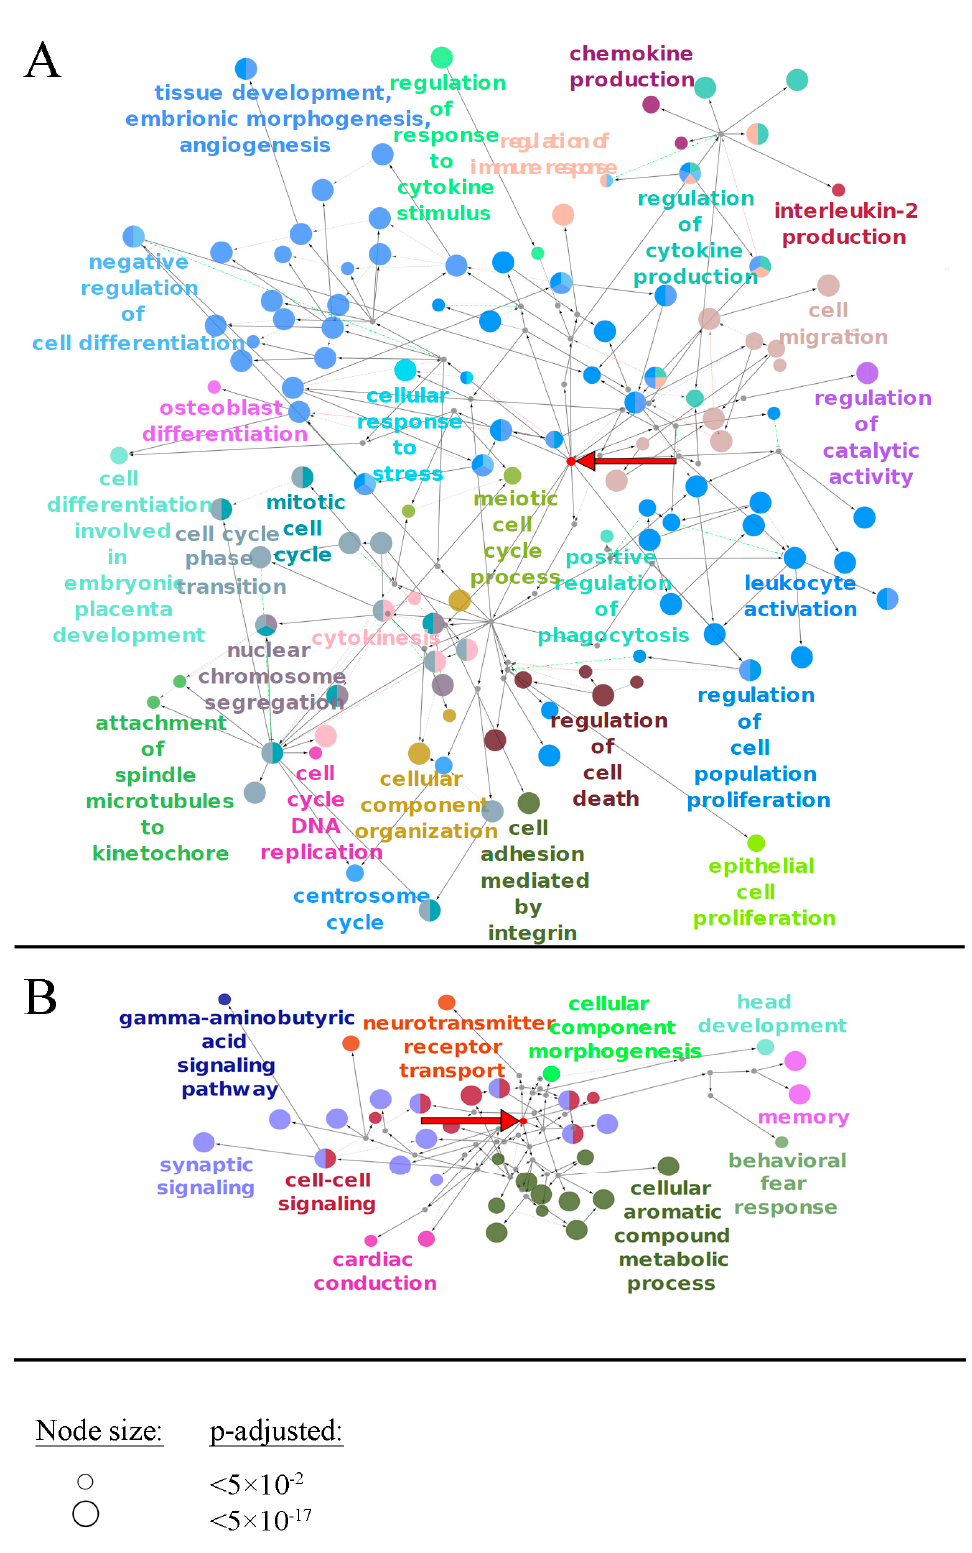
Figure 5. Gene Ontology tree (from null to third level) for genes linked with negative ( A ) and positive ( B ) prognoses in LGG. Bold red arrow shows a root node (null level of GO tree). Small grey nodes are parental nodes connecting the root node with significant terms of the third level. The size of the node reflects its adjusted p -value. Each group of terms is marked by a specific color; if a term belongs to several groups, it has several colors,